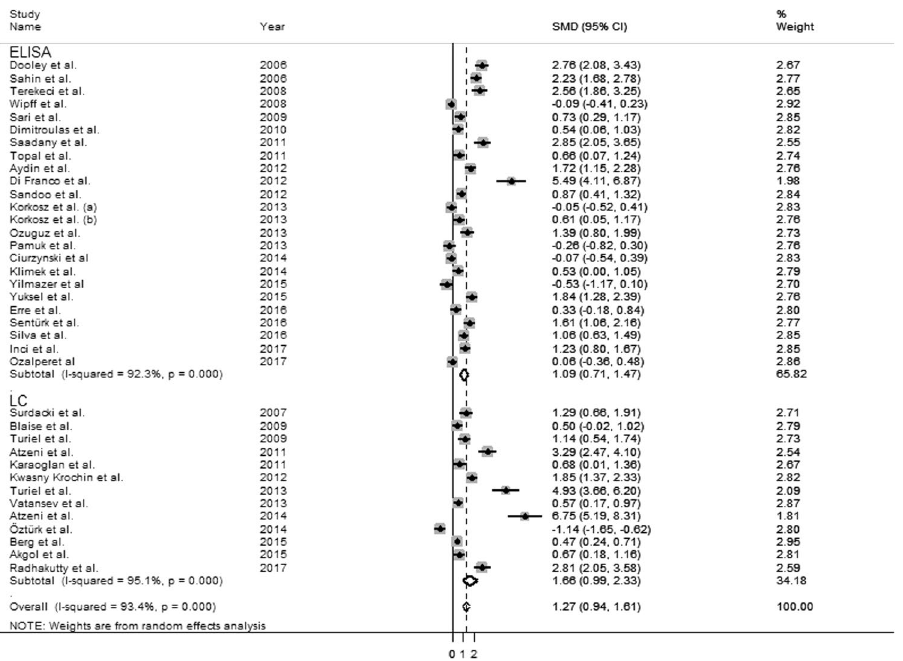
Figure 8. Forest plots depicting the standard mean (SMD) of dimethylarginine (ADMA) concentrations in rheumatic diseases (RDs) according to analytical techniques (liquid chromatography-LC vs